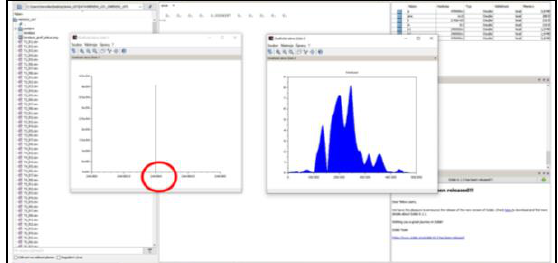
Fig. 11. Data processing procedure by the method of mutual correlation between signals. Fig. 12. Tripol showing the geometrical principle of ultrasonic tomograf